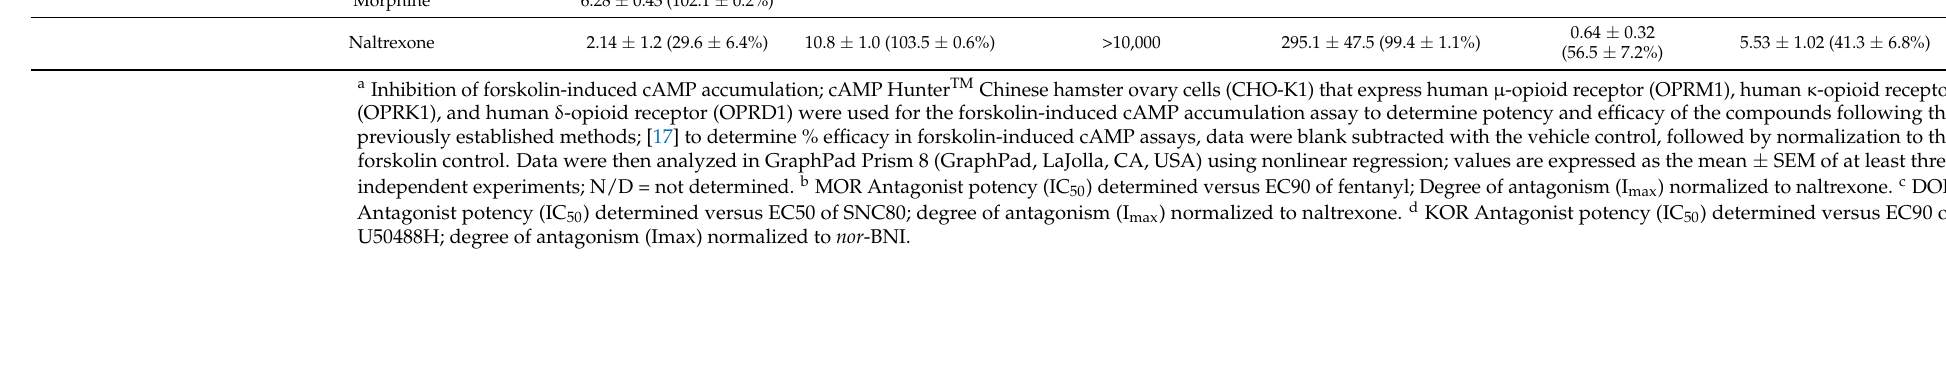
vehicle control, followed by normalization to the forskolin control. Data were then analyzed in GraphPad Prism 8 (GraphPad, LaJolla, CA, USA) using nonlinear regression; values are expressed as the mean ± SEM of at least three independent experiments; N/D = not determined. b MOR Antag- onist potency (IC 50 ) determined versus EC90 of fentanyl; Degree of antagonism (I max ) normalized to naltrexone. c DOR Antagonist potency (IC 50 ) determined versus EC50 of SNC80; degree of